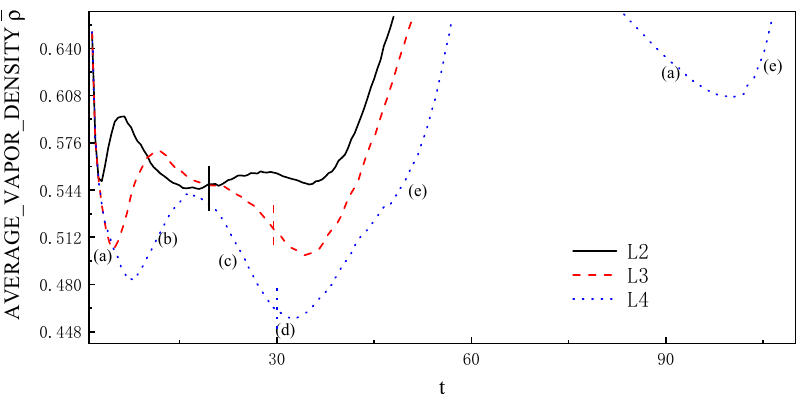
Figure 7. Average vapor density of the first bubble with time. Note that the vertical line is the moment when the bubble reaches maximum volume. Five bubble stages are concluded: ( a ) inertial controlled, ( b ) intermediate, ( c ) heat-diffused controlled, ( d ) precollapse, ( e ) collapse.